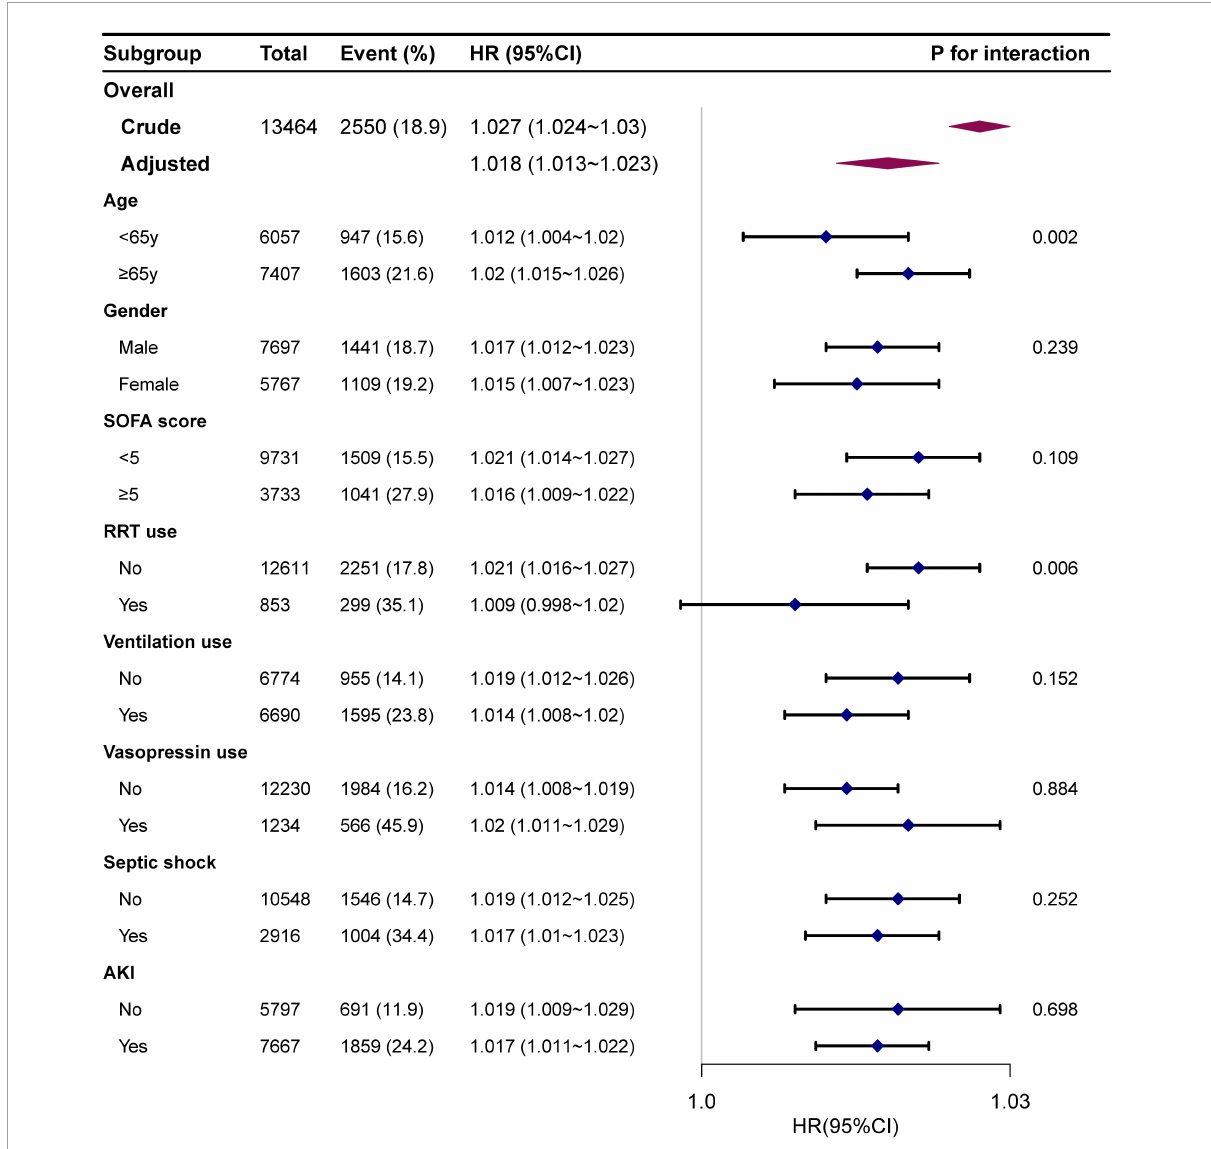
FIGURE3 Association between BAR and in-hospital mortality according to baseline characteristics. Each stratification was adjusted for all factors of Model 3 in Table 2 except for the stratification factor itself.